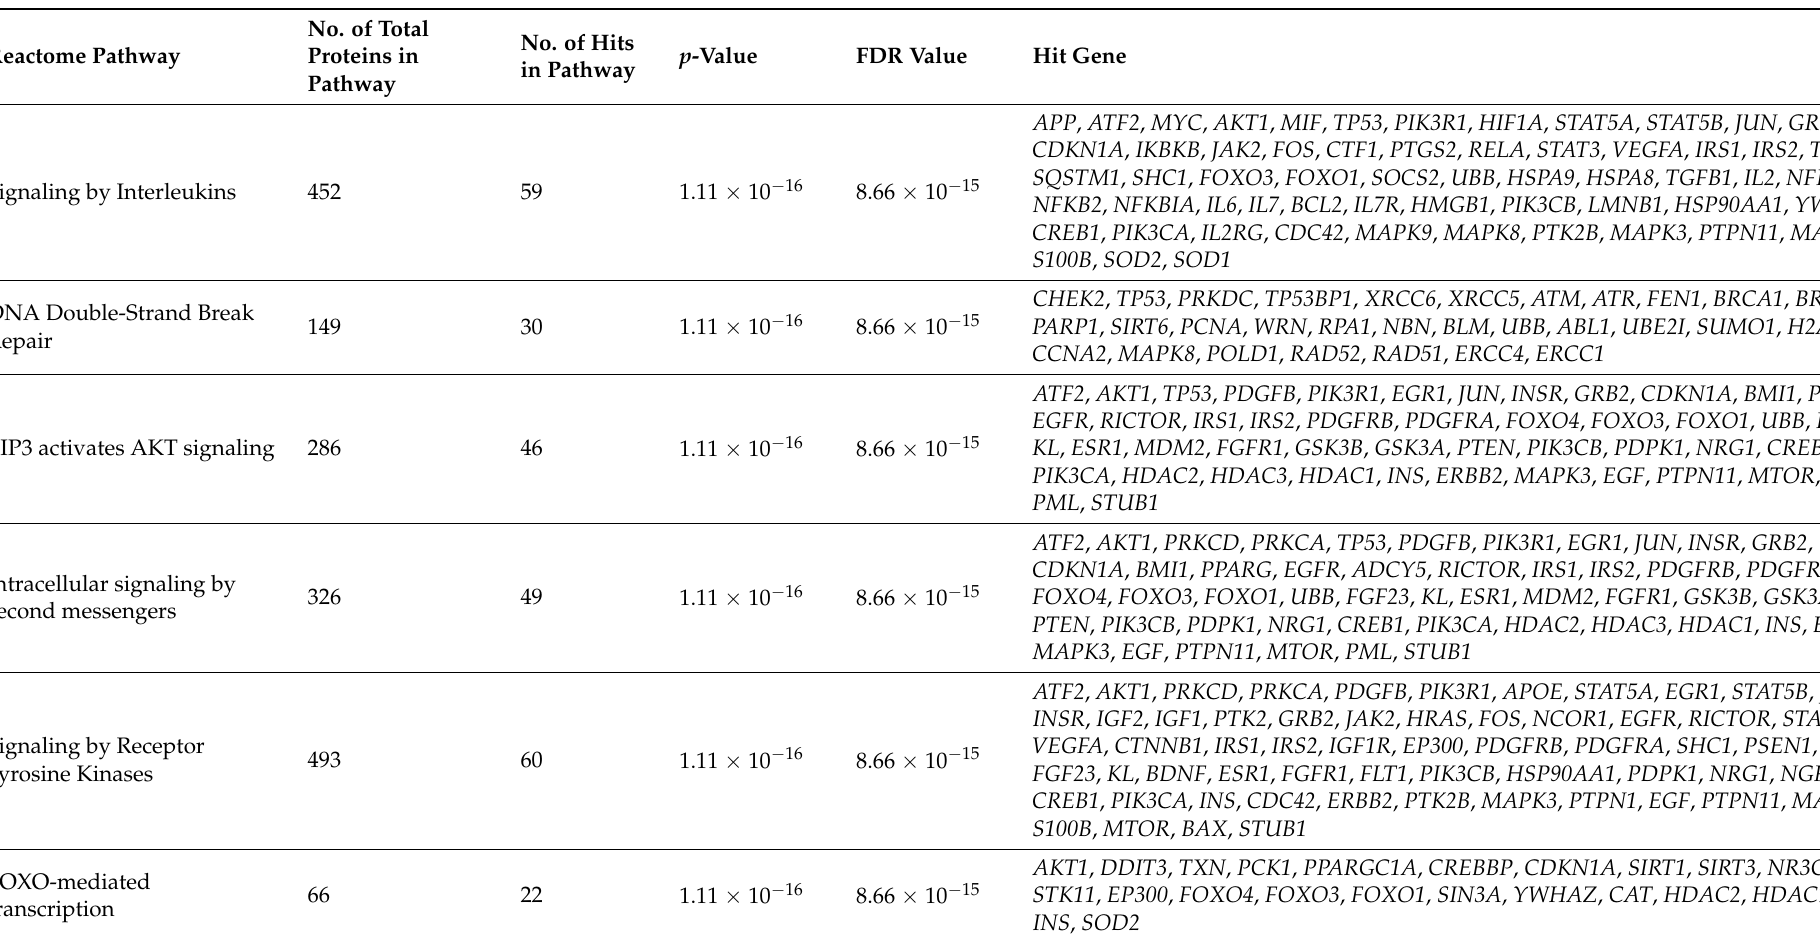
Table 2. Reactome pathway enrichment analysis results—GenAge (AR)